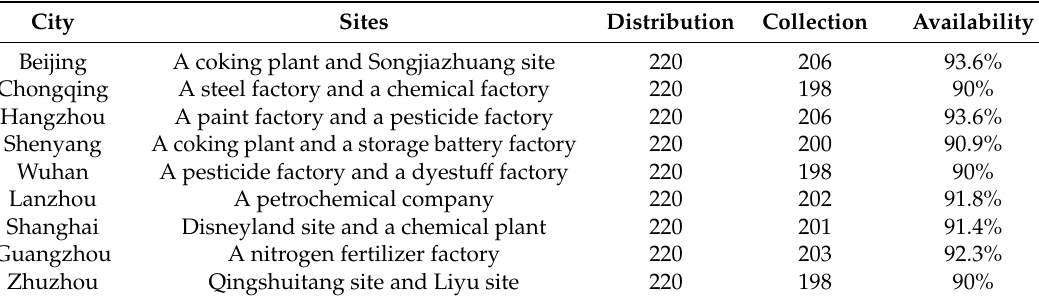
Table 1. Questionnaire distribution and collection.